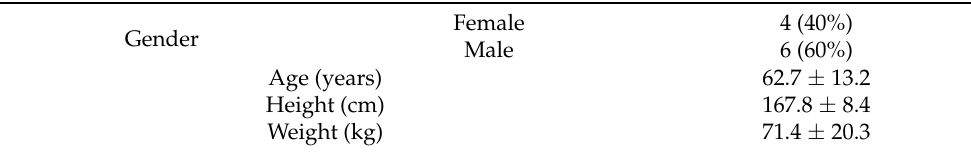
Table 1. Summary of subjects in the study ( n = 10).